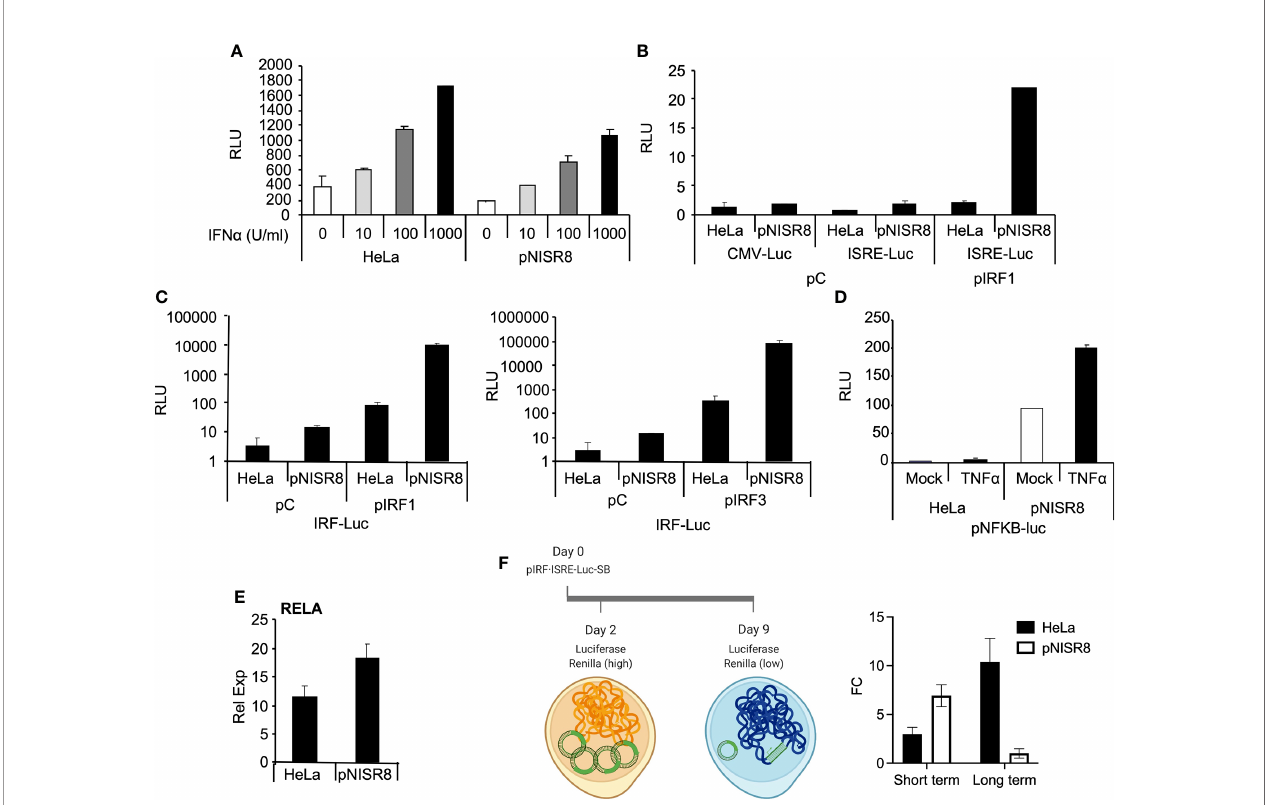
FIGURE 5 | Analysis of the response of episomic or genomic reporter genes in ISR8 -disrupted cells after IRF1 or RELA overexpression and IFN a treatment. (A) Evaluation of relative luciferase units (RLU) in the indicated cells transfected for 48 h with pISRE-Luc and treated with the indicated doses of IFN a . A plasmid expressing renilla´s luciferase was also co-transfected in all cases as a control. (B) Similar to A but cells were co-transfected with pCMV-Luc, pISRE-Luc and a control plasmid or pIRF1. (C) Similar to C but cells were transfected with pIRF-Luc and pIRF1 or pIRF3. (D) Relative luciferase units (RLU) in the indicated cells transfected with pNF- k B-Luc and mock-treated or treated with TNF a for 6 h. (E) RELA mRNA was evaluated in HeLa and pNISR8 cells by qRT-PCR and normalized to GAPDHmRNA. (F) Schematicof the experiment isshown to the left. The indicated cells were transfected with pSB-IRF·ISRE-Luc and plasmids expressing renilla´s luciferase andthe transposase. Forty-eight hoursor 9 days after transfection and puromycinselection, luciferase signal was measuredand foldchange (FC)ofRLU in IFN a - treatedand untreatedcells isshown.Errorbarsindicate standarddeviations. Experiments were performed at least fourtimes and a representative fi gure